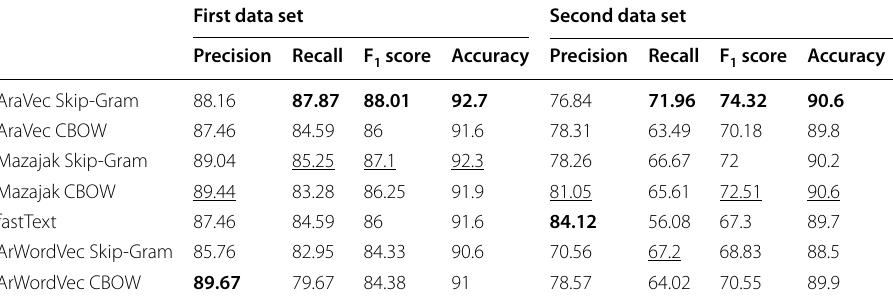
Bold numbers indicate the best value while underlined numbers represent the second‑best